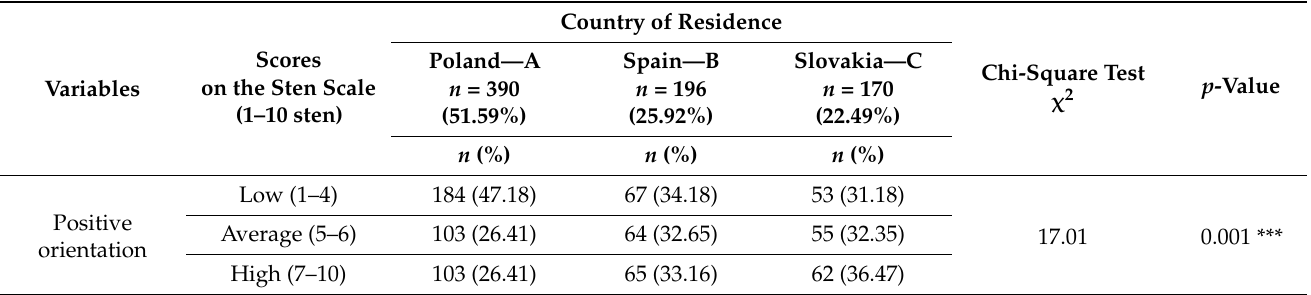
Figure 1. Positive orientation—diversity of results in the Polish, Spanish and Slovak studies. Statisti- cally significant: *** p < 0.001. Table 3. Percentage of scores for positive orientation on the sten scale in the Polish, Spanish and Slovak